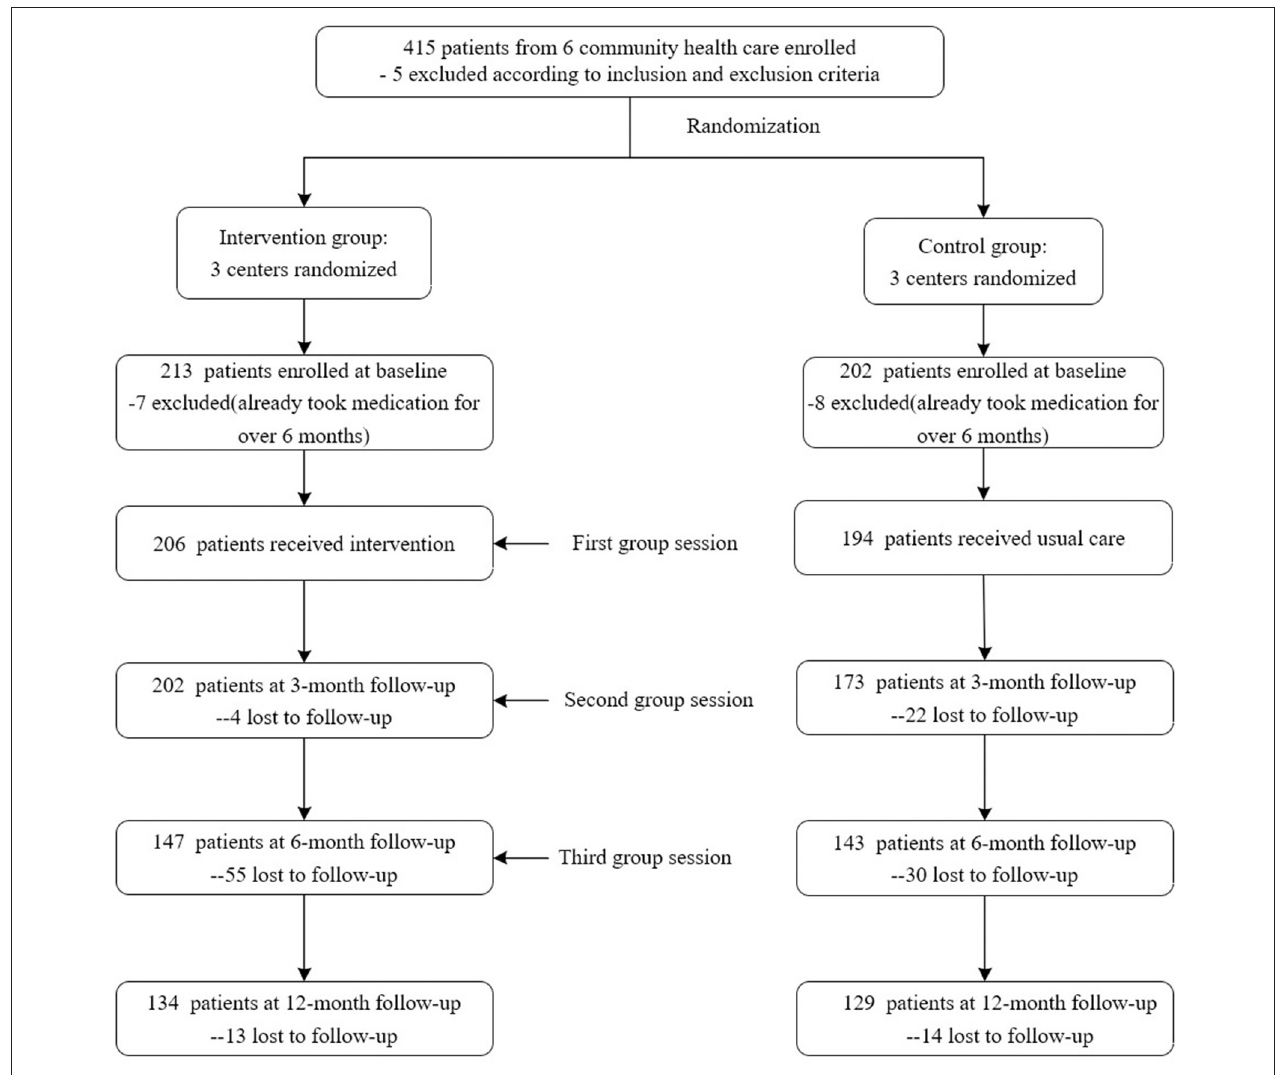
FIGURE 1 | Participation flow